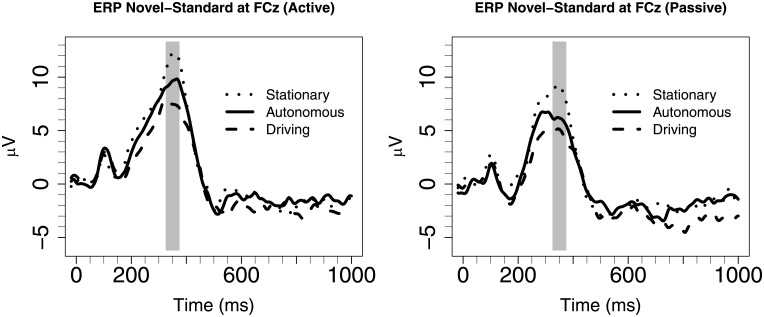
Grand-average difference ERPs (novel minus standard) (microvolts) in different driving modes (lines), relative to onset of auditory stimulus (0 s) for the active condition (left panel) and the passive condition (right panel).The shaded area indicates the epoch of frontal P3. Both autonomous (solid line) and driving (dashed line) show a reduced frontal P3 peak compared to stationary (dotted line).